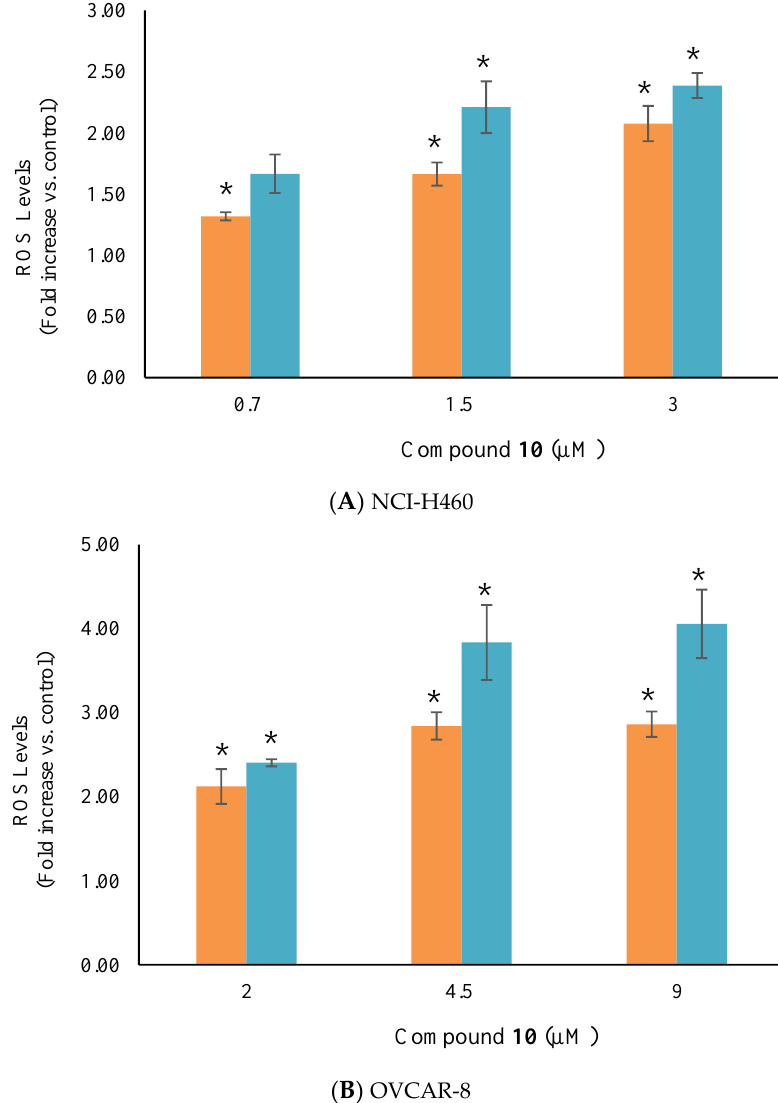
Figure 3. ROS production generated by compound 10 in NCI-H460 ( A ) and OVCAR-8 ( B ) cell lines. Cells were treated with the compound for 48 (orange) and 72 h (blue). ROS generation was analyzed by flow cytometry after labelling with carboxy-H 2 DCFDA (see the text for more details). ROS levels are indicated as fold-increase vs. control (non-treated cells). Values were taken from 10,000 total events. Data are presented as mean ± SE of at least three independent experiments. Differences versus untreated control cells were considered significant at * p <